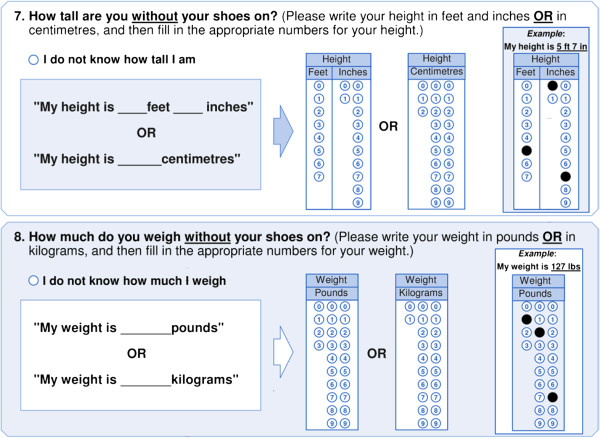
COMPASS questionnaire measures of height and weight used to calculate BMI.